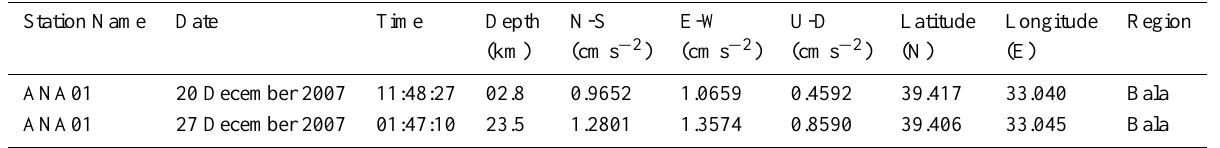
Table 1. Parameters of Bala (Ankara) Earthquakes (http://angora.deprem.gov.tr/rapor/bala.htm, Fig. 3 Seismic hazard settings of Turkey (modified from USGS 2008)